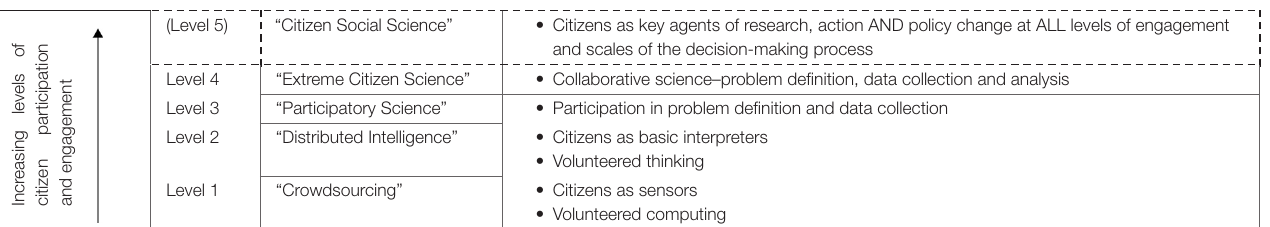
TABLE 1 | Levels of participation and engagement (adapted from Sui et al.,